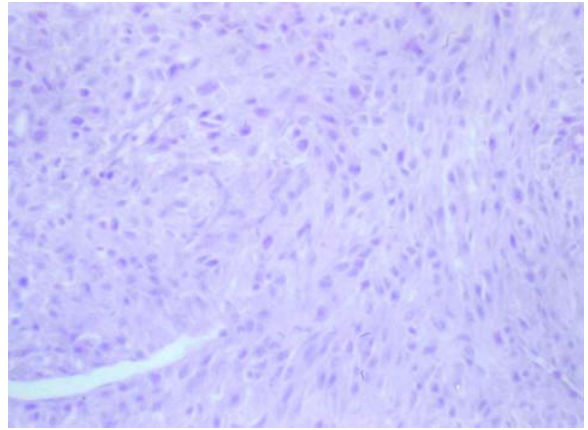
Figure 3 – Leiomyosarcoma of the penis (HE,